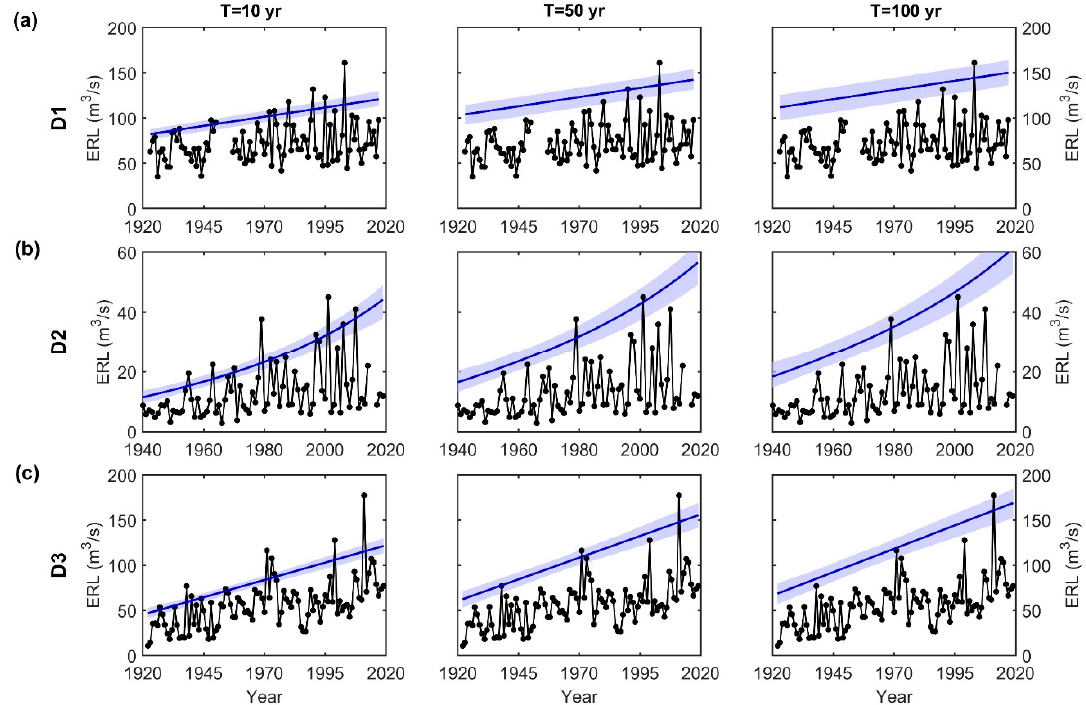
Figure 4. The point estimates of the effective return levels ( ERLs ) (blue lines) and their uncertainty (shaded areas) at the three given return periods ( T ) (10-, 50-, and 100-yr) for the three datasets, ( a ) D1, ( b ) D2, and ( c ) D3.